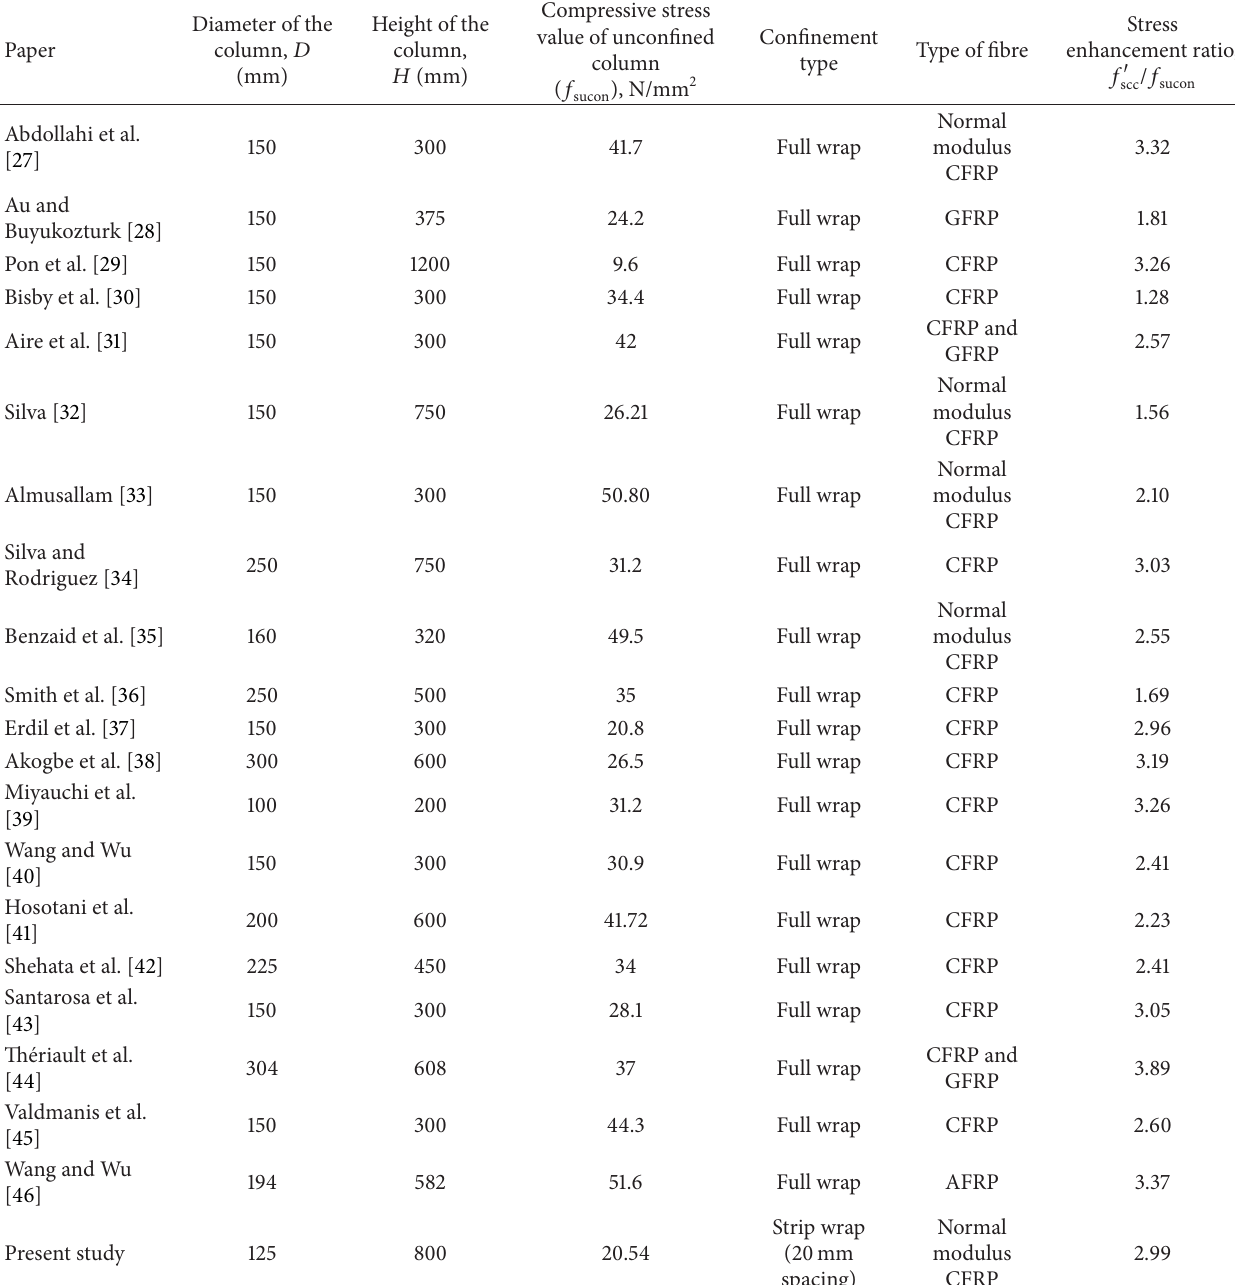
Table 2: Test results of previous studies: stress enhancement